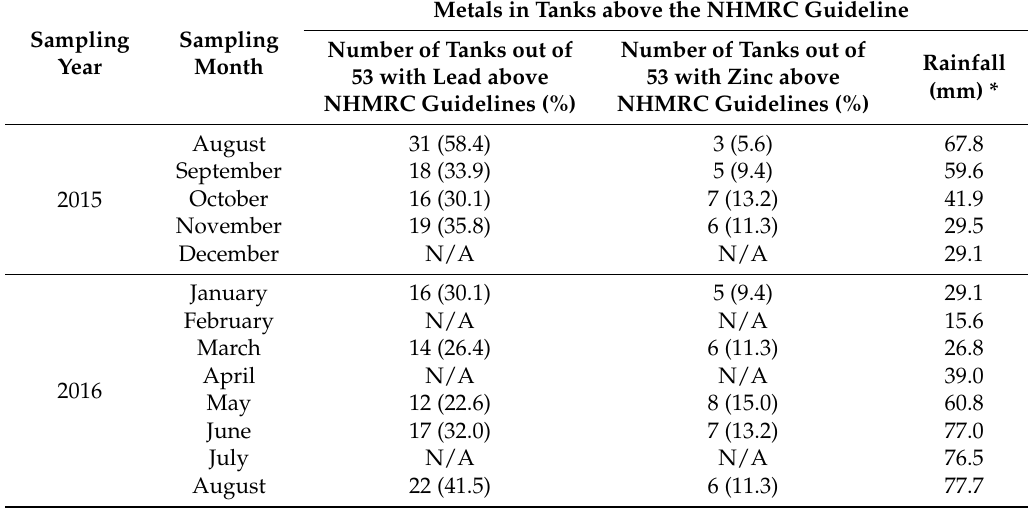
Table 3. Sampling rounds and lead and zinc levels in rainwater